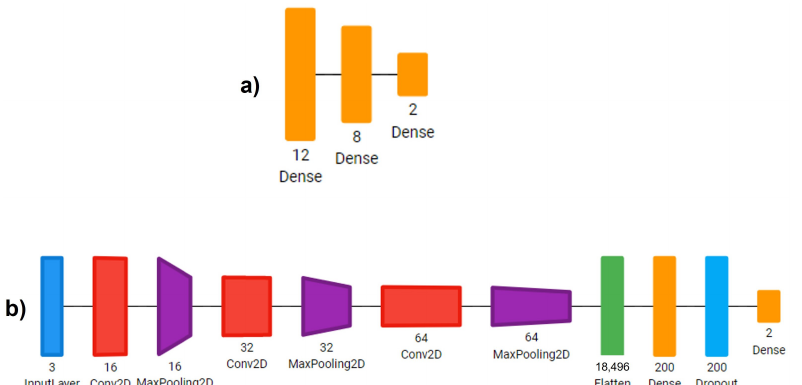
Figure 2. Simplest architecture designs used in this study. ( a ) Sequential CNN architecture. ( b ) Sim- ple CNN architecture (Diagrams of the architectures were developed using Net2Vis [53] tool for visualizing Deep Learning models).